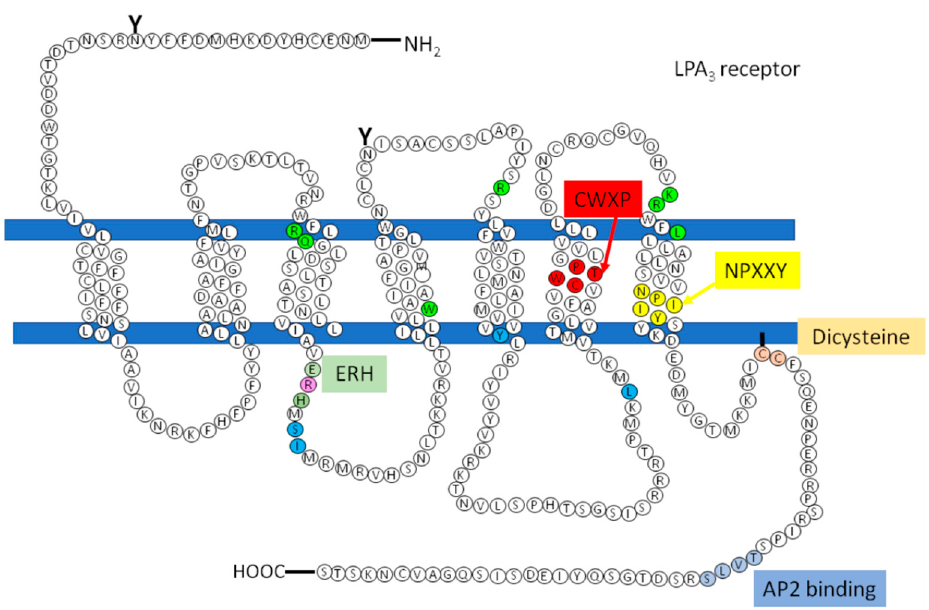
Figure 5. LPA 3 receptor structure, domains and sites that regulate this receptor. Image shows the amino acid sequence and the organization of the LPA 3 receptor with three extracellular loops, three intracellular loops, the seven transmembrane domains, the extracellular amino terminus (-NH 2 ), and the intracellular carboxyl terminus (-COOH). Colored boxes indicate conserved motifs putatively relevant for activation and regulation of the LPA 3 receptor. Putative sites where LPA interacts with LPA 3 are shown in green, while proposed places where GPCRs could be recruiting G proteins are marked in blue and purple (R, arginine that is also part of the ERH motif). “Y” indicates a potential glycosylation site, and the line joining one of the cysteines to the membrane is a putative palmitoylation site.